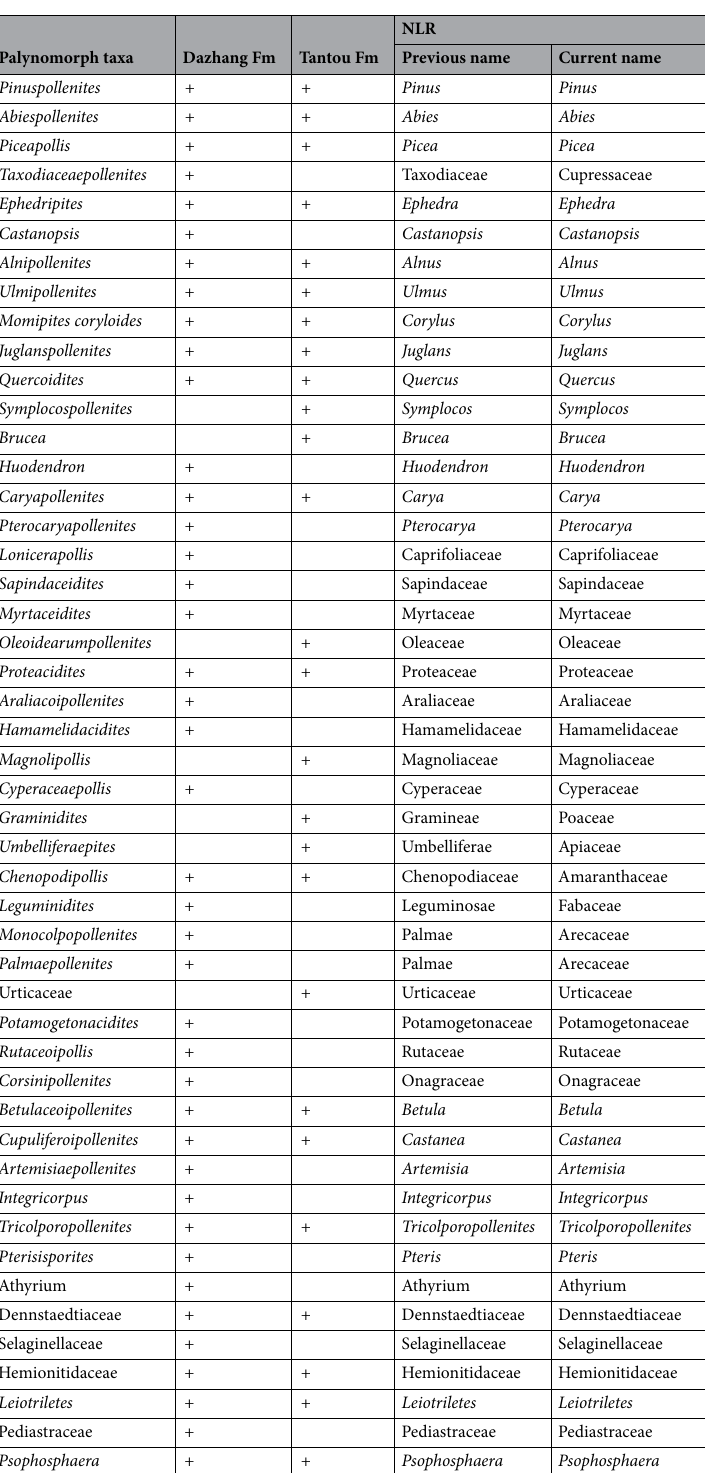
Table 2. List of palynomorphs from the Late Palaeocene to Early Eocene in the Tantou Basin and their nearest living relatives (NLRs) (Wu and Ding 37 ; Zhang et al. 36 ). Fm . formation; NLR nearest living